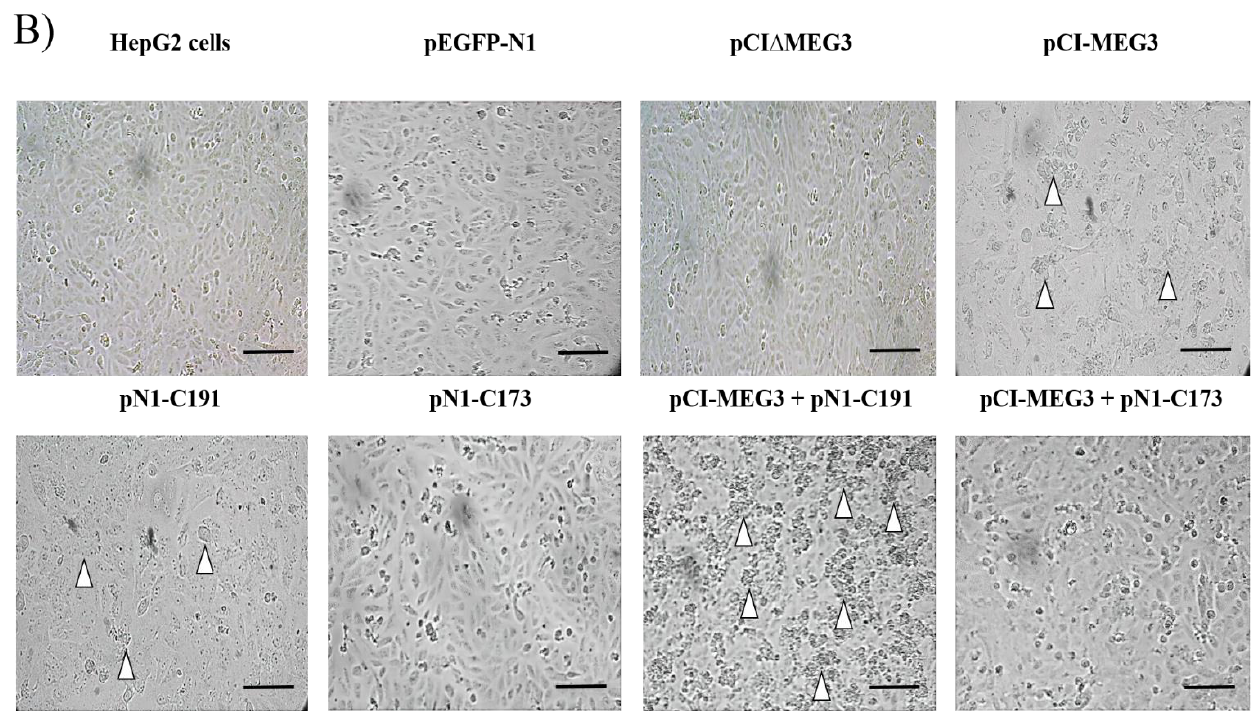
Figure 1. ( A ): Cell viability of transfected HepG2 cells with plasmids pEGFP-N1, pCI ∆ MEG3, p-CI-MEG3, pN1-C191, pN1-C173, p-CI-MEG3 + pN1-C191 and p-CI-MEG3 + pN1-C173 compared to control HepG2 cells, following incubation period 48 h and 72 h. The mean of three independent replicates was used to calculate these data values. Data presented as mean ± SD. (*) represents p -value < 0.05 and (**) represents p -value < 0.01 compared to control untransfected HepG2 cells, pEGFP-N1 and pCI ∆ MEG3. Colored lines represent the significance of cell viability in HepG2 cells between each sample and its control. Controls are divided into (a) HepG2 cells (Black), (b) HepG2 cells transfected with pEGFP-N1 (Red), and ( c) HepG2 cells transfected with pCI∆MEG3 (Blue). ( B ): Representative Photomicrographs showing the viability of HepG2 cells transfected with different plasmids after an incubation period of 72 h with the magnification of 20× . (∆) represents the accumulation of dead cells and apoptotic bodies. Scale bar 100 µm.